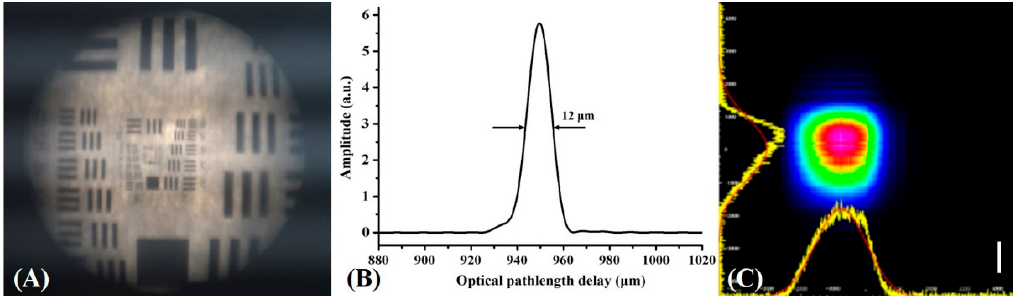
Figure 3. ( A ) The test target white light image at 15 mm; ( B ) Optical coherence tomography (OCT) point spread function (PSF); ( C ) laser ablation beam profile at 15 mm (scale bar: 1000 μ m).